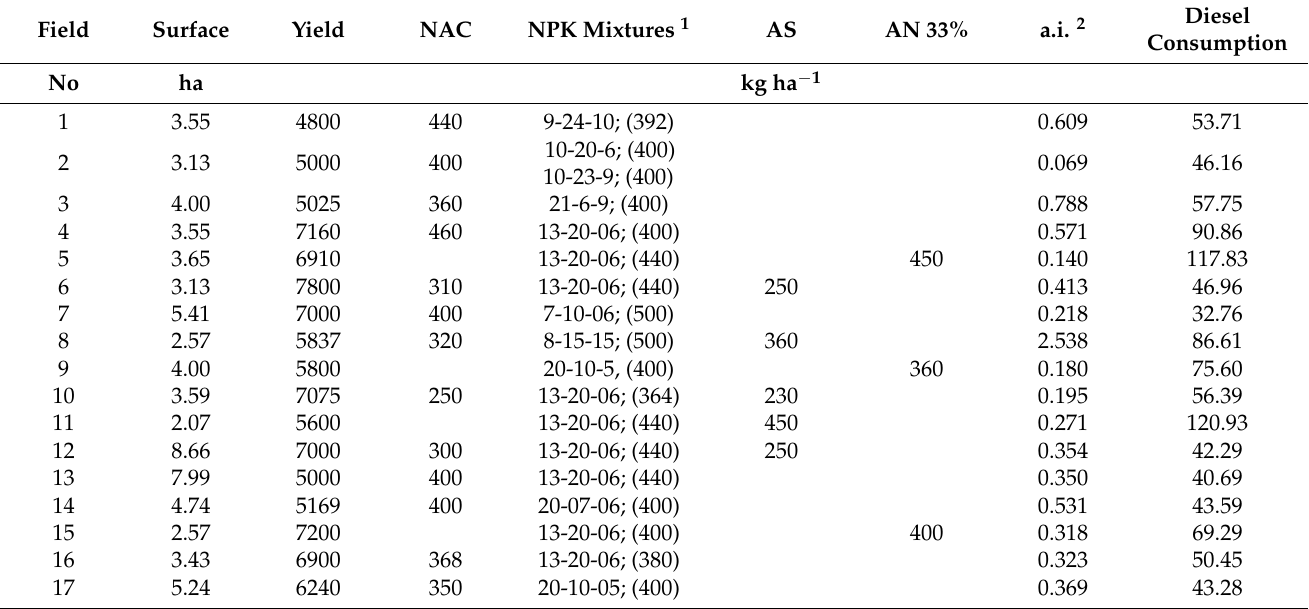
Table A1. Data inventory for barley production in 17 fields in Araba/ Á lava that helped to define the case study used in the